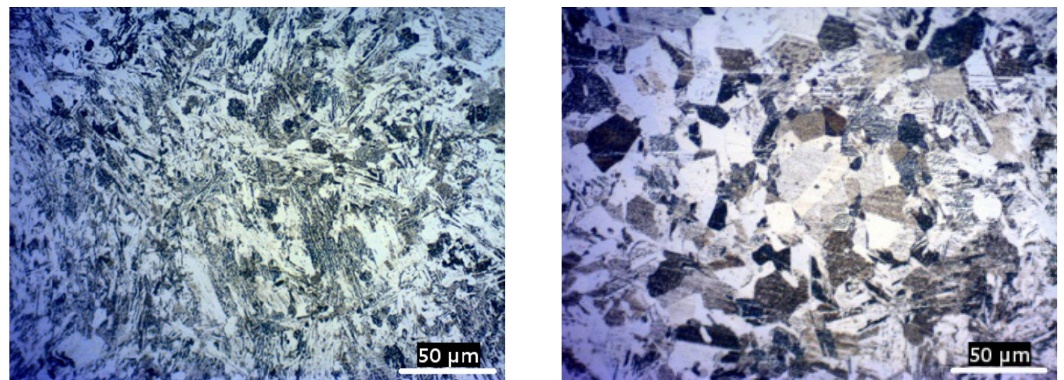
Figure 13. A lamellar microstructure produced at a higher beam current of 18 mA ( left ), compared to an equiaxed structure produced at 6 mA ( right ); both with the standard scan strategy.